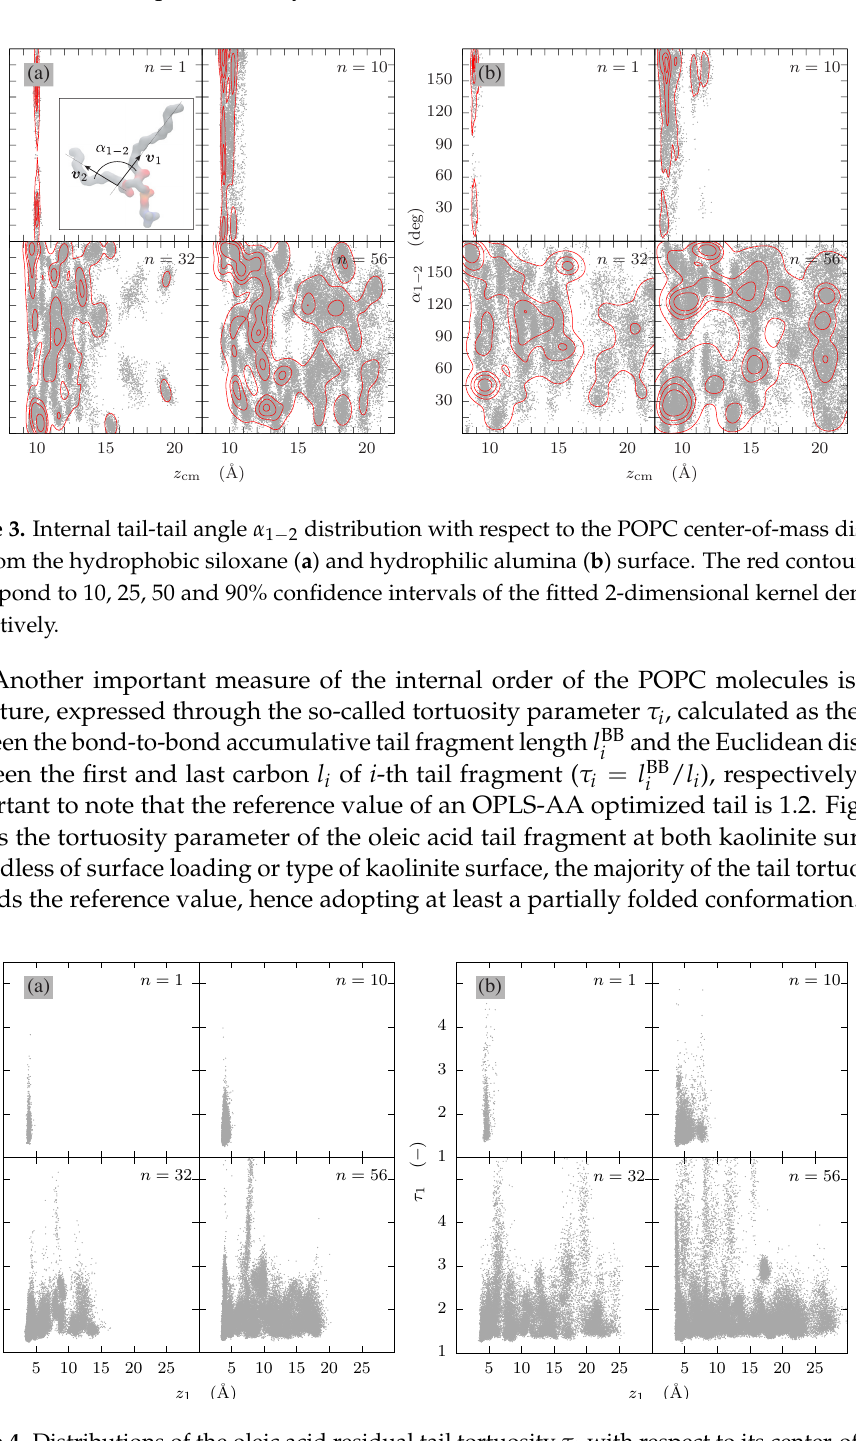
Figure 4. Distributions of the oleic acid residual tail tortuosity τ 1 with respect to its center-of-mass distance to the kaolinite basal oxygens z 1 of the hydrophobic siloxane ( a ) and hydrophilic alumina ( b ) surface, respectively. Four different values of the surface loading parameter n are